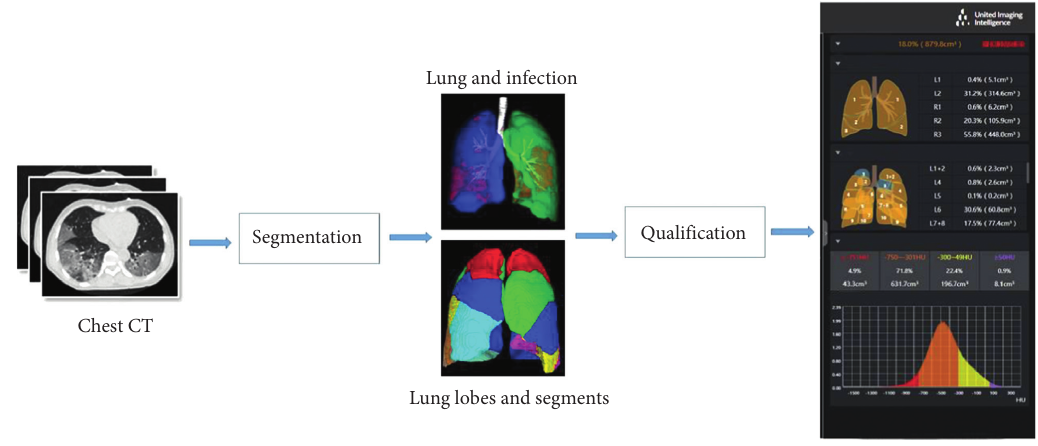
Figure 1: A flowchart for calculating the percentages of infection in the whole lung